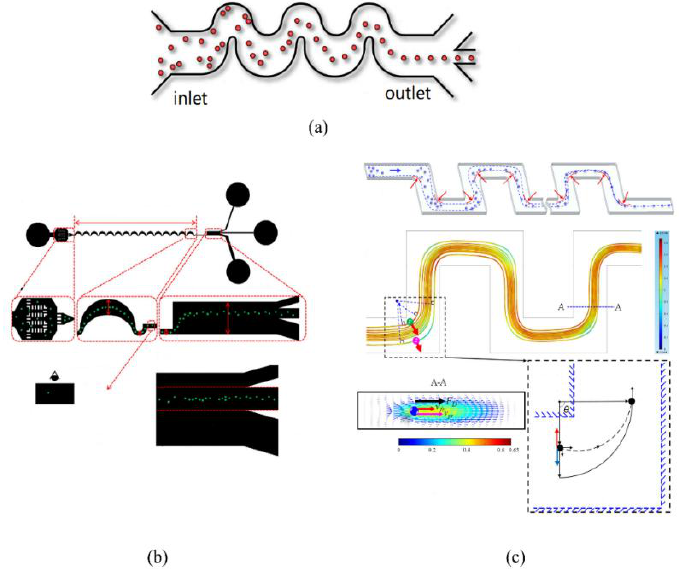
Figure 9. Applications of sinusoidal-channel inertial microfluidics. ( a ) System put forward to separate cells with high throughput of 1 g/h. Ref. [78]; ( b ) Microfluidic concentration for harvesting cyanobacterium Synechocystis sp. PCC 6803. Ref. [80]. Copyright (2017), with permission from Elsevier